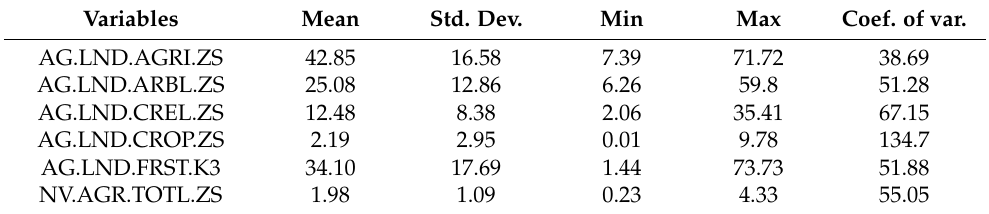
Table 3. Summery statistics of the items used in evaluating the agricultural land-use determinants. Variables Mean Std. Dev. Min Max Coef. of